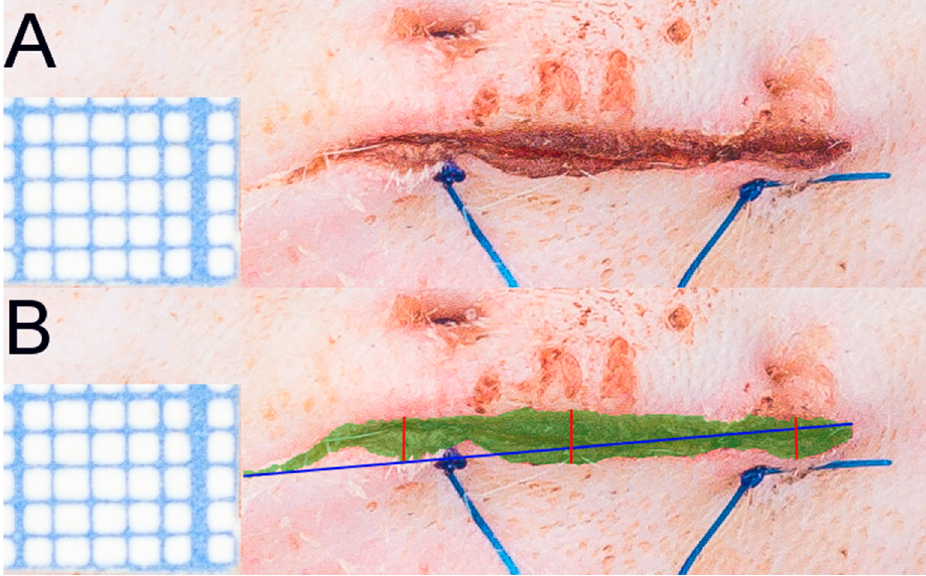
Figure 9. ( A ) A 3rd day wound with a surgical microscale (1 sqr–1 mm), ( B ) wound with marked area (green zone), length (blue line), and width (red lines) in ImageJ by a blinded